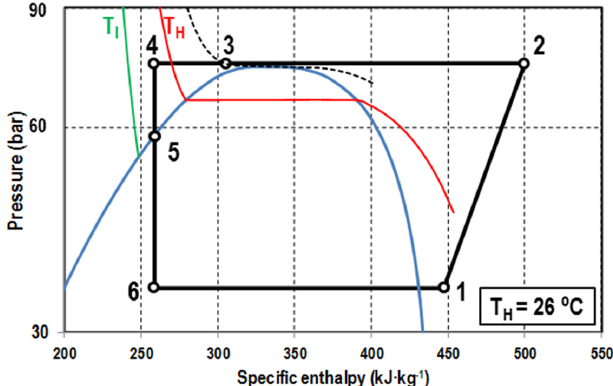
Figure 2. Pressure-enthalpy diagram of mechanical subcooling (MS) cycle in subcritical conditions.